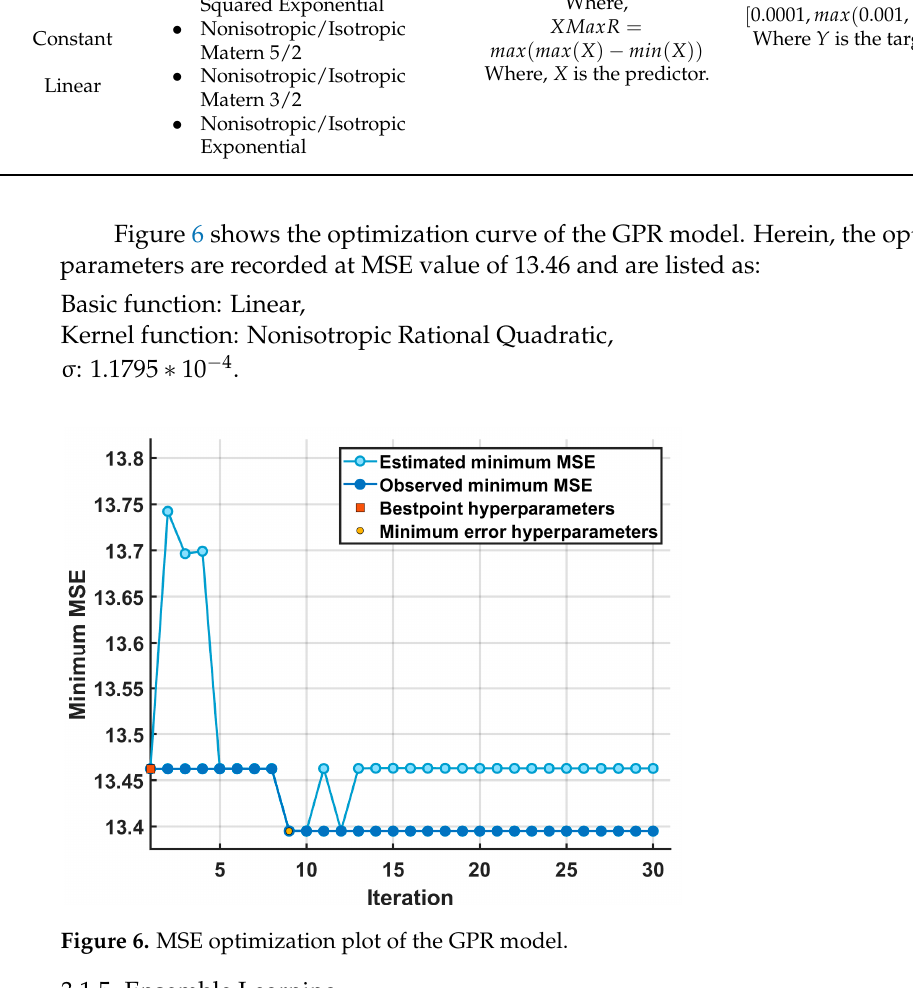
Table 3. The ranges of the ensemble model optimizable hyperparameters.